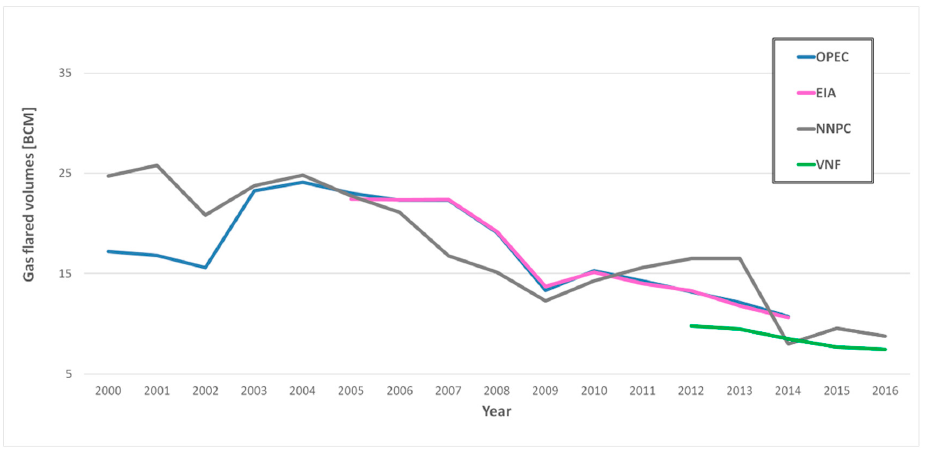
Figure 2. Annual values of gas flared volumes (in BCM) for Niger Delta region provided by NNPC (grey line), OPEC (blue line), EIA (pink line) and VNF (green line). (grey line), OPEC (blue line), EIA (pink line) and VNF (green